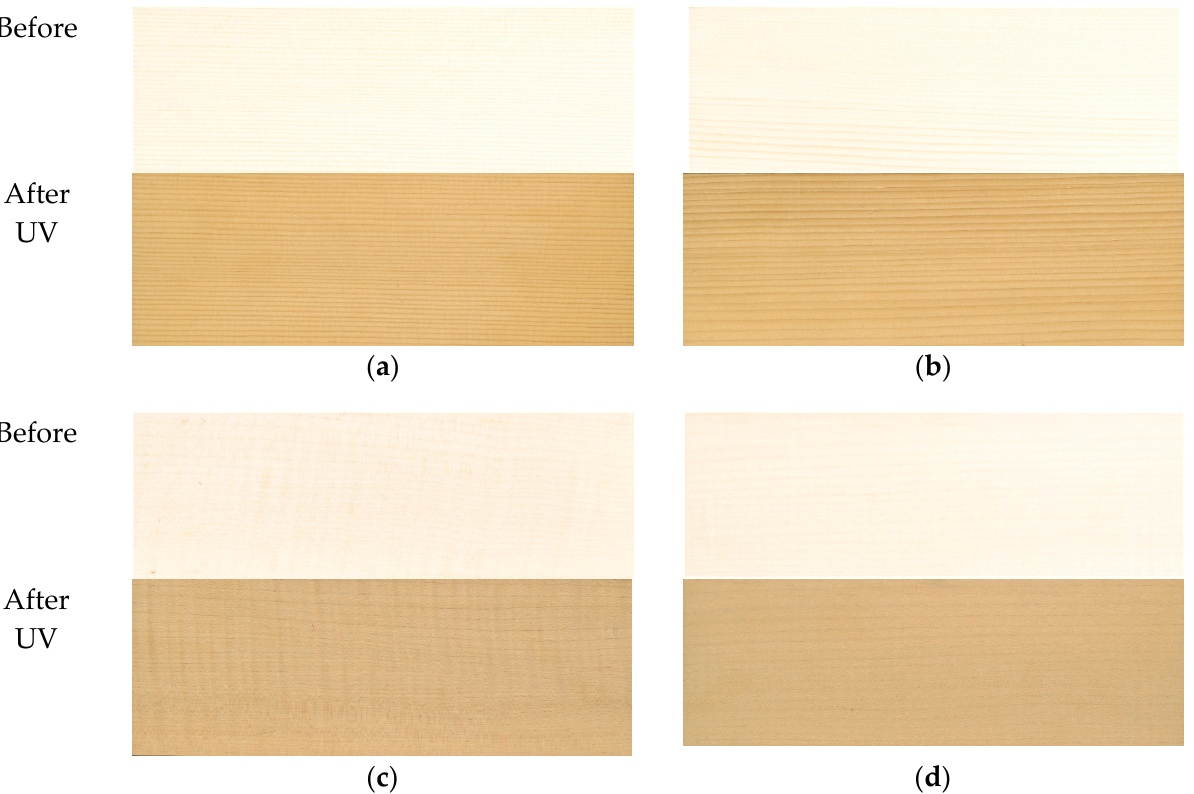
Figure 5. The variation of color parameters with an increase in UV exposure time: ( a ) lightness of spruce samples; ( b ) lightness of sycamore maple samples; ( c ) redness of spruce samples; ( d ) redness of sycamore maple samples; ( e ) yellowness of spruce samples; ( f ) yellowness of sycamore maple samples.